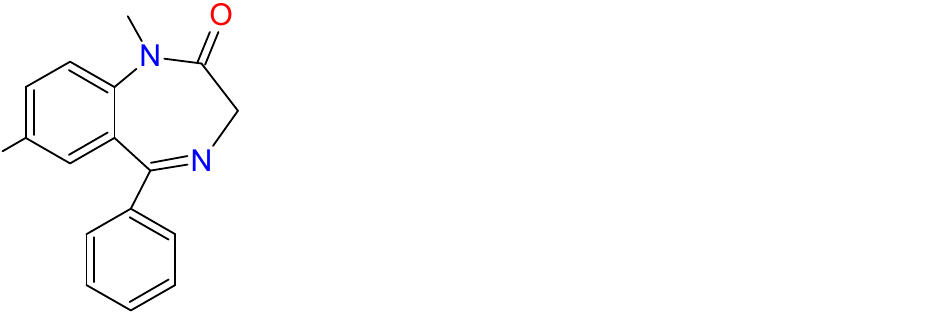
Figure 8. Chemical structure of Diazepam. It is believed that, under its effects, Stephen Paddock killed 58 persons during a concert in Las Vegas (USA), the first of October 2017.